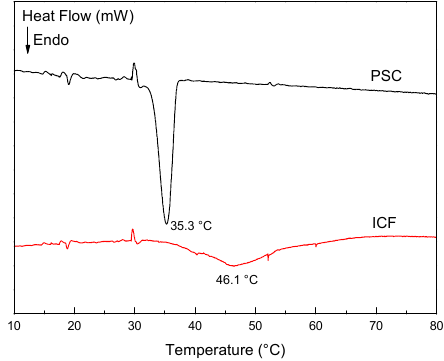
Figure 1. Comparison of DSC heating traces between aqueous 5% dispersions of ICFs (red line) and PSCs (black line).